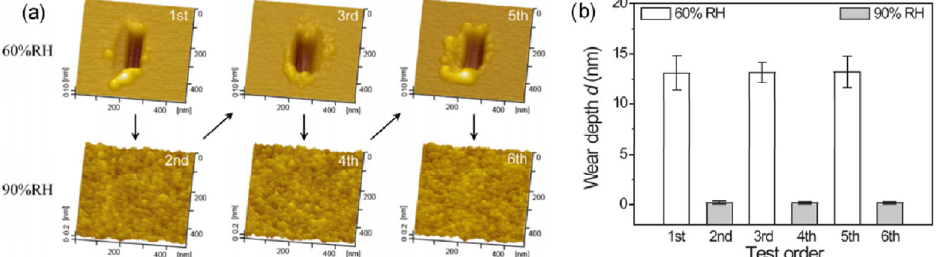
Fig. 15 Nanowear of silicon against SiO 2 tip in humid air with RHs of 60% and 90%. (a) AFM images and (b) wear depth of nanowear tracks on silicon surface formed at 60% and 90% RH, respectively. Applied load, sliding speed, and sliding cycle were 3 μ N, 2 μ m/s, and 200. Reproduced with permission from Ref. [38], © American Physical Society